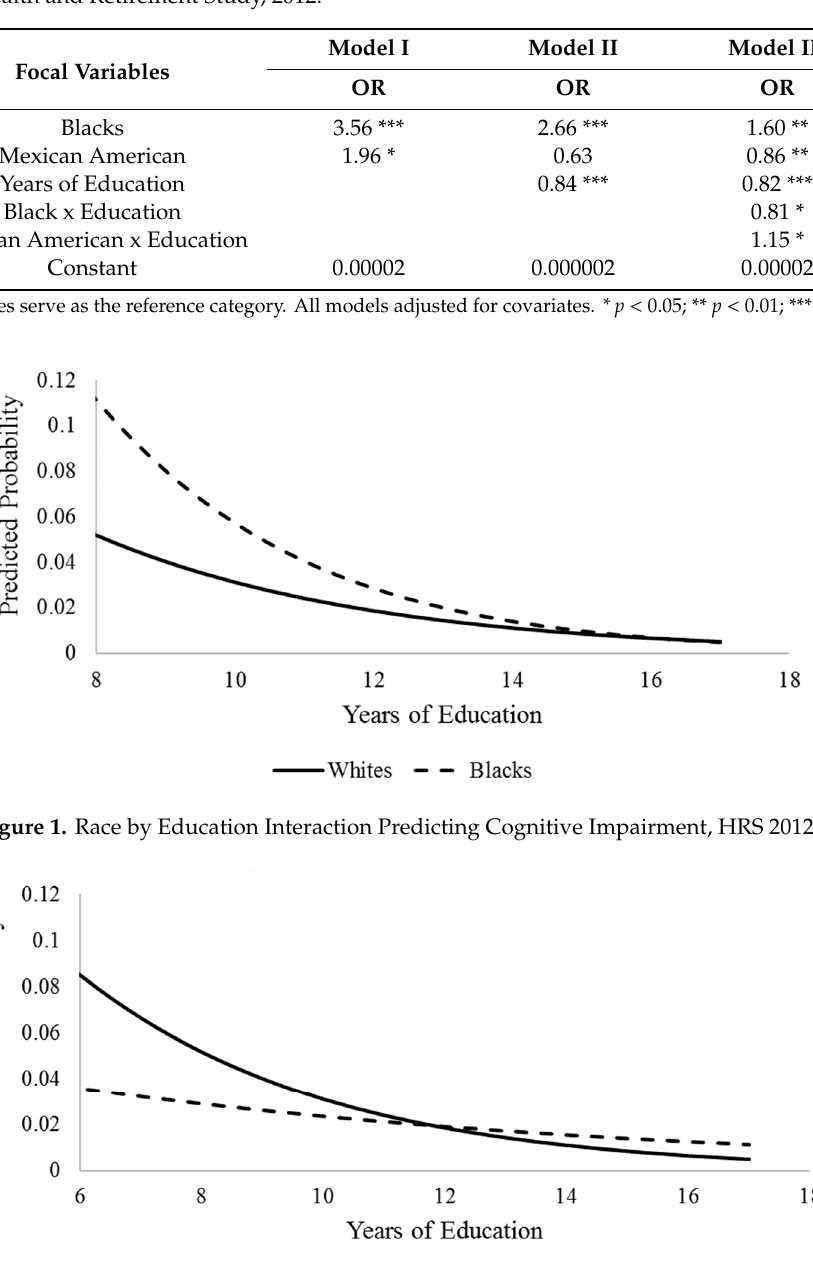
Table 2. Odds ratios from logistic regression models examining cognitive impairment among U.S. adults, Health and Retirement Study, 2012.